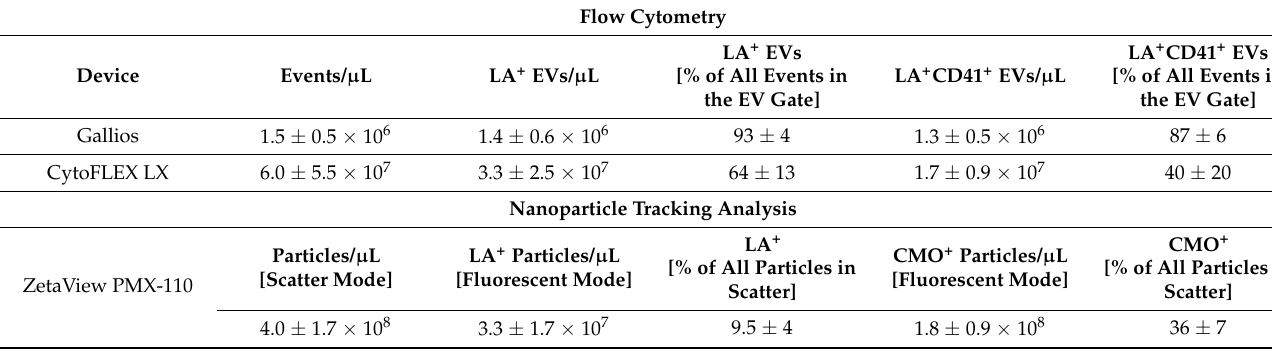
Figure 2. Comparative analysis of platelet-derived EVs using flow cytometry and NTA. ( A ) number of events detected by flow cytometry with Gallios vs. CytoFLEX LX; ( B ) percentage of LA + events detected by flow cytometry using Gallios or CytoFLEX LX vs. percentage of LA + particles detected by NTA in fluorescence mode; the percentages refer to the entirety of events detected with flow cytometry and NTA, respectively; ( C ) percentage of LA + CD41 + events for Gallios vs. CytoFLEX LX; ( D ) size distribution of platelet-derived EVs determined by NTA. Size distribution of EVs determined by S-NTA and F-NTA after staining with the unspecific membrane dye CMO (F-NTA CMO + ) or with LA-AF555 (F-NTA LA + ) as marker for phosphatidylserine exposing vesicles; ( E ) particle concentration detected by S-NTA and F-NTA (CMO + and LA + ); ( F ) percentage of CMO + and LA + particles detected by F-NTA. Data are presented as mean ± SD (n = 8, same batches used for all measurements; * p < 0.05; ** p < 0.01; *** p < 0.001). Table 1. EV counts obtained for platelet-derived EVs by flow cytometry (Gallios vs. CytoFLEX LX) and by NTA (scatter mode vs. fluorescence mode after staining with CMO or